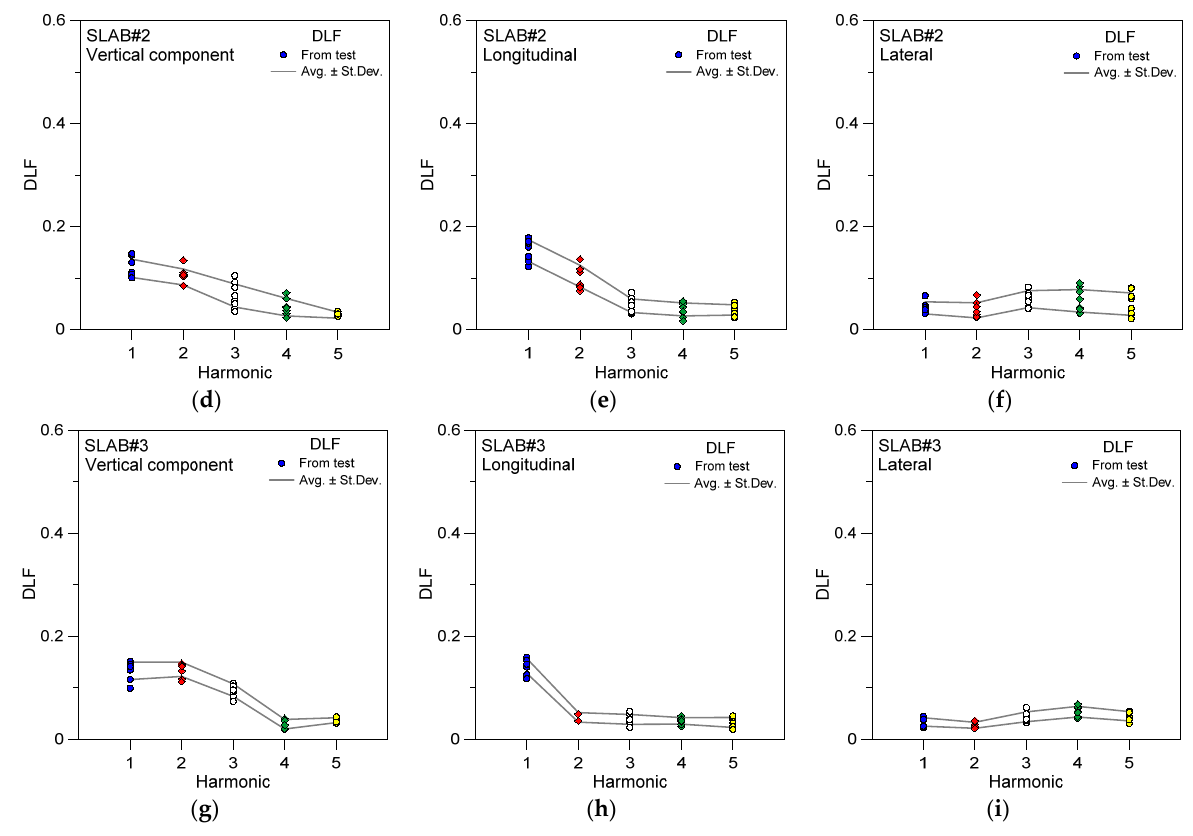
Figure A1. Experimentally derived DLF trends (average ± standard deviation, with evidence of raw experimental outcomes), as a function of harmonic order, for a single adult volunteer under normal walks on ( a – c ) rigid floor (SLAB#1) or ( d – f ) flexible SLAB#2 and ( g – i ) SLAB#3 transparent systems, with evidence of DLF values corresponding to ( a , d , g ) vertical, ( b , e , h ) longitudinal, and ( c , f , i ) lateral